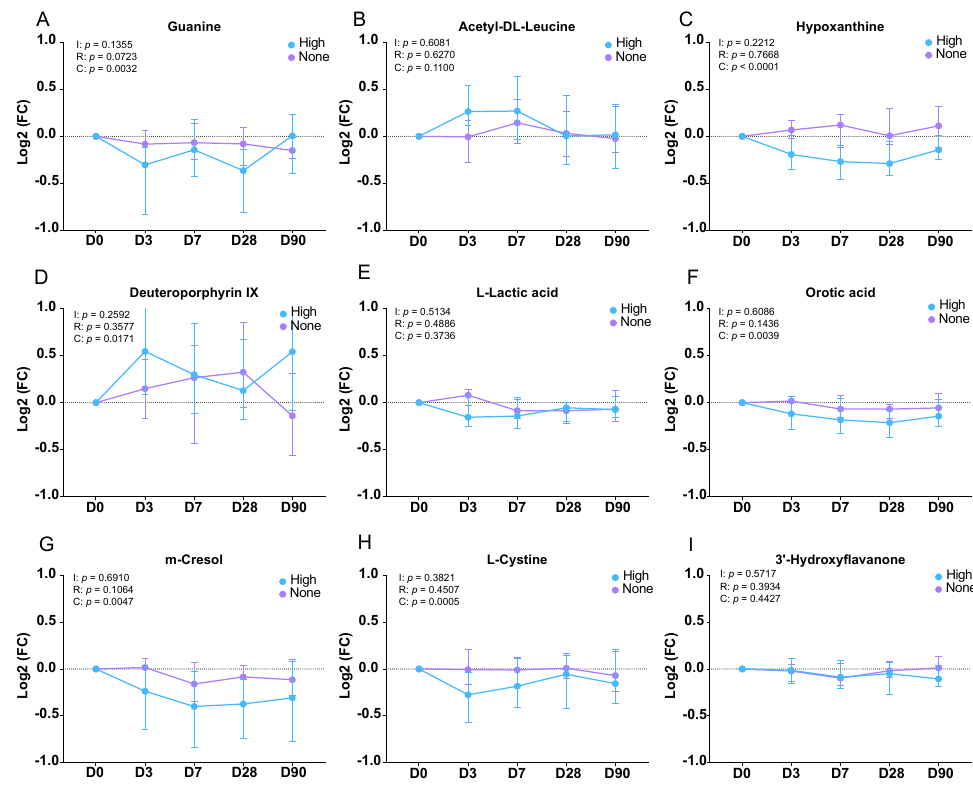
Figure 6. Metabolite time-course dynamics of the IAV vaccine response. ( A – I ) Line plot of the relative change in the subject urine metabolite levels with respect to the baseline over the 90-day time-course. For each metabolite, error bars represent the standard deviation of the fold change compared to the baseline, and the Y-axis represents the Log2 values. Each metabolite was analyzed in a two-way ANOVA. I = interaction of the two factors, R = row factor, days post-vaccination, C = column factor, seroconversion status (High-responder or